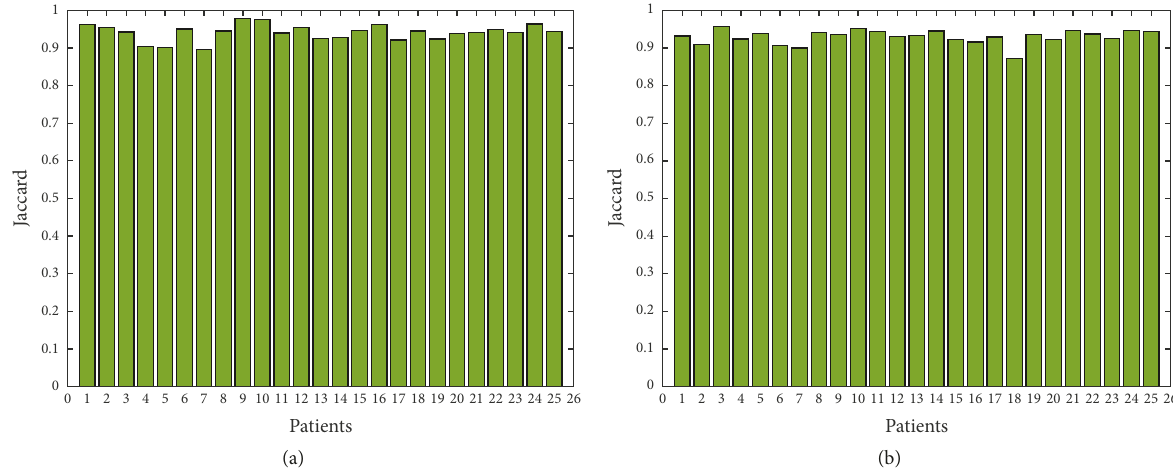
Figure 15: Jaccardinthermal images for 50 patients;(a) 25with high-gradetaken from BRATS 2012; (b) 25with low-gradetaken from BRATS